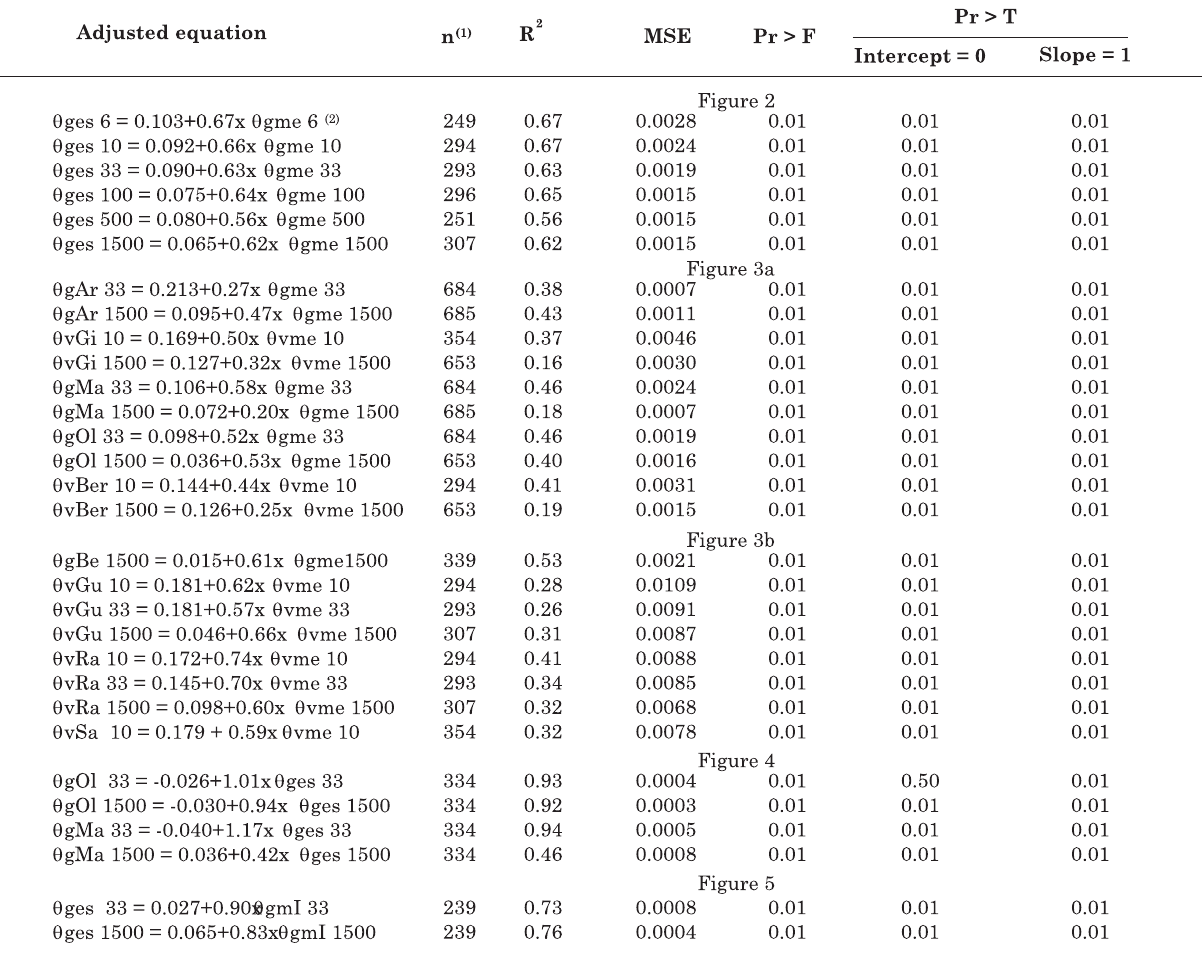
Table 5. Statistical parameters and equations for the data and adjustments expressed in figures 2 to